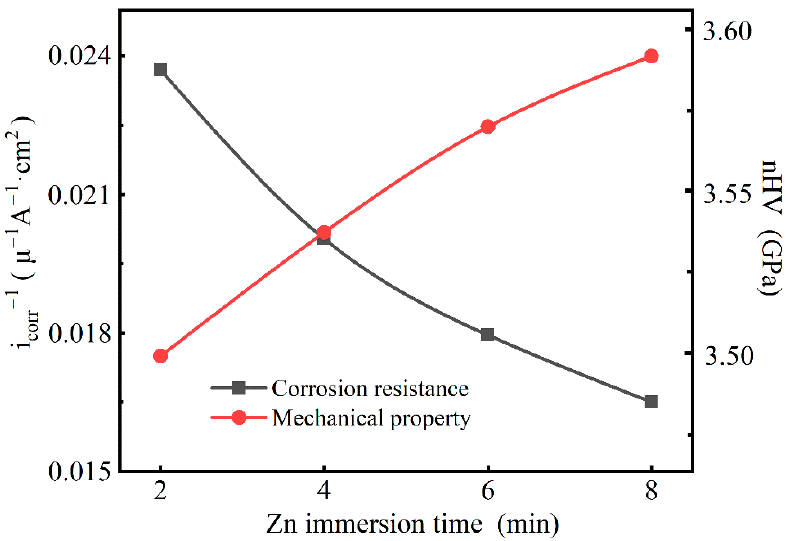
Figure 12. The qualitative mechanical property and corrosion resistance variation of the Mg/Al intermetallic compounds β -phase (Mg 17 Al 12 ) and γ -phase (Mg 2 Al 3 ), with various Zn immersion times (I) Zn 2 min, (II) Zn 4 min, (III) Zn 6 min, and (IV) Zn 8 min.